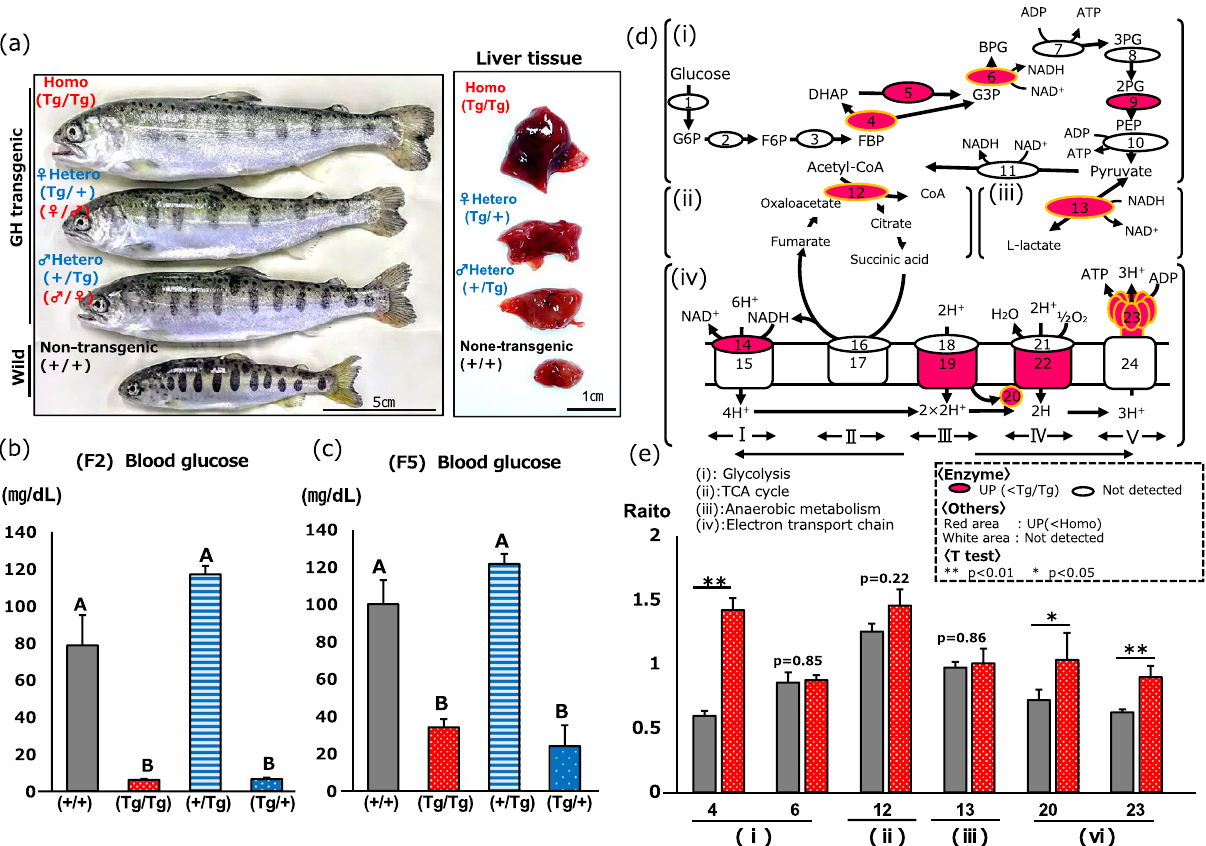
Figure 1. Generation of the GH-transgenic fish and iTRAQ proteomics. ( a ) GH-transgenic and non-transgenic fish used for the experiments. (Tg/+) indicates that the fish is the result of fertilization of (Tg/Tg) eggs and (+/+) sperm. (+/Tg) indicates that the fish is the result of fertilization of (+/+) eggs and (Tg/Tg) sperm. (Tg/Tg) and (+/+) fish were used for iTRAQ and mtDNA analysis. ( b and c ) Measurement of blood sugar concentration in different generations (F2 and F5). Different letters indicate a significant difference ( p < 0.05; one-way ANOVA followed by Dunnett T3 test (F2) and Bonferroni (F5). F2, n = 6; (+/+), n = 10; (Tg/Tg), n = 10; (+/Tg), n = 10; (Tg/+). F5, n = 4; (+/+), n = 8; (Tg/Tg), n = 5; (+/Tg), n = 5 (Tg/+). ( d ) Mapping of detected proteins by iTRAQ into glycolysis (i), TCA (ii), anaerobic metabolism (iii), and the electron transport chain (iv). Red circles and red coloring denote the upregulation of proteins relative to non-transgenic siblings. Blank circles and white color denote proteins that were not detected by iTRAQ. Orange circles represent proteins confirmed by western blotting. ( e ) Signal intensity in western blots. (See “Supplementary Information” and “Supplementary figures” for the mapped enzymes indicated in e ). Red denotes homozygous (Tg/Tg) fish, and gray denotes non- transgenic (+/+) fish. * p < 0.05; ** p < 0.01. Vertical bars represent